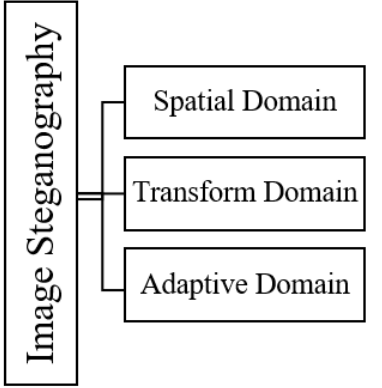
Figure 1. Categorization of Image Steganography .